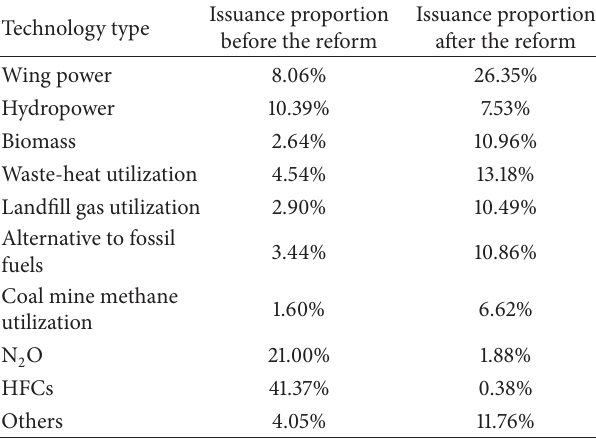
Table 4: The CER proportion of all kinds of technology type before and after the